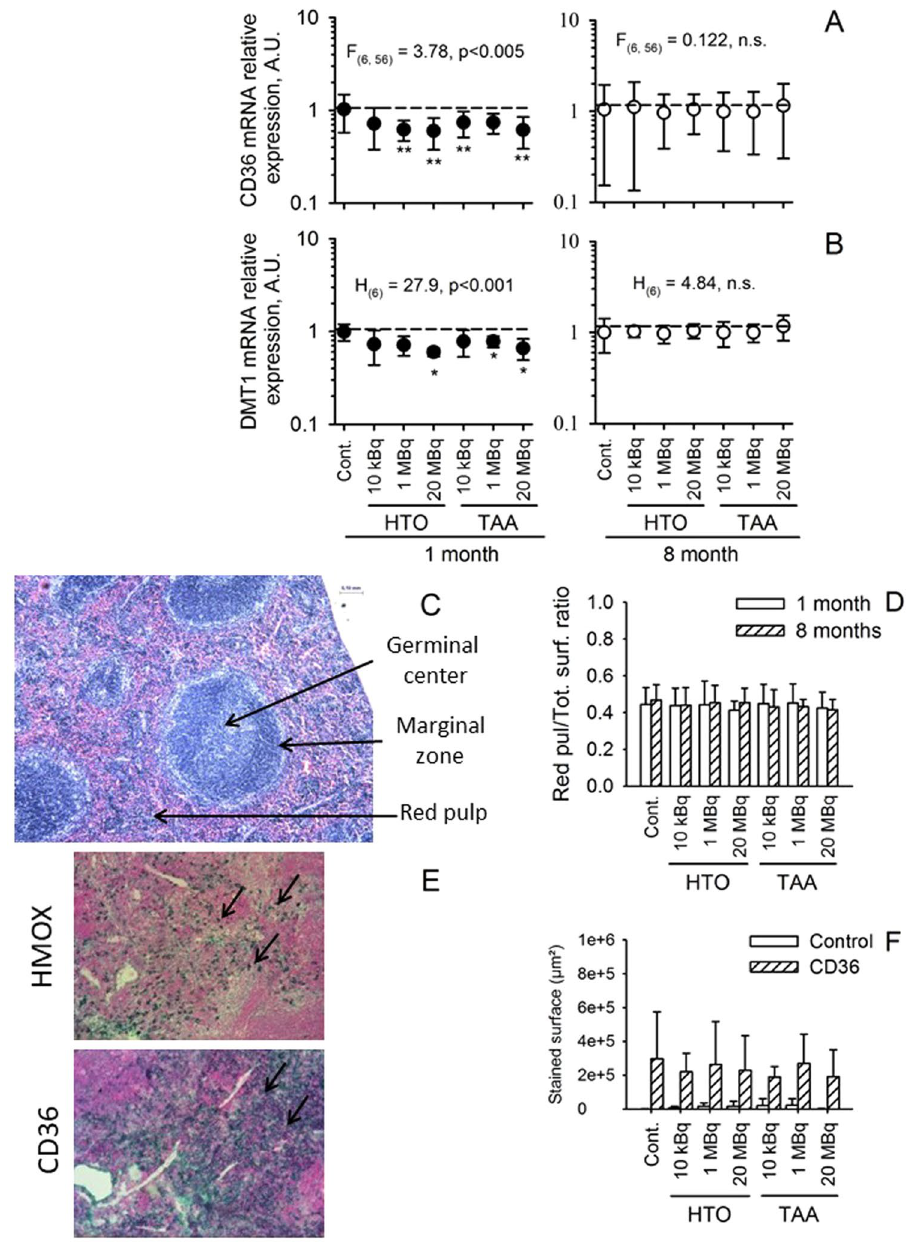
Figure 5. Analysis of the spleen in exposed animals. ( A ) CD36 mRNA and ( B ) DMT1 mRNA relative expression in the spleen of animals after either one or eight months of exposure to tritium. Significant changes in mRNA relative expression was observed after one month of exposure as compared to the control group (dashed line) (one-way ANOVA test), but not after 8 months of exposure. ( C , D ) Gross morphological analysis of spleen after one or eight months of exposure. ( C ) Representative morphology of HES-stained spleen in a control animal after one month of exposure, with the red pulp appearing in pink, germinal center as the dark blue area and marginal zone appearing in light blue. ( D ) Histo-morphological analysis of the spleen after one month of exposure (open bars) or eight months or exposure (hatched bars). The ratio of the red pulp to the spleen surface showed no change as a function of the group of exposure or to the duration of exposure (two-way ANOVA test). ( E , F ) Immuno-histological analysis of HMOX and CD36 expression in the spleen of exposed animals after one month of exposure. ( E ) Representative HMOX staining showing nuclear staining mainly in the germinal center (arrows, upper panel) and representative CD36 staining showing a homogeneous cytoplasm staining in the red pulp (arrows, lower panel) in a control animal after one month of exposure. ( E ) Immuno- histo-morphological analysis of CD36 staining in the spleen of mice exposed for one month. No significant changes were observed in CD36 expression according to the group of exposure (one-way ANOVA